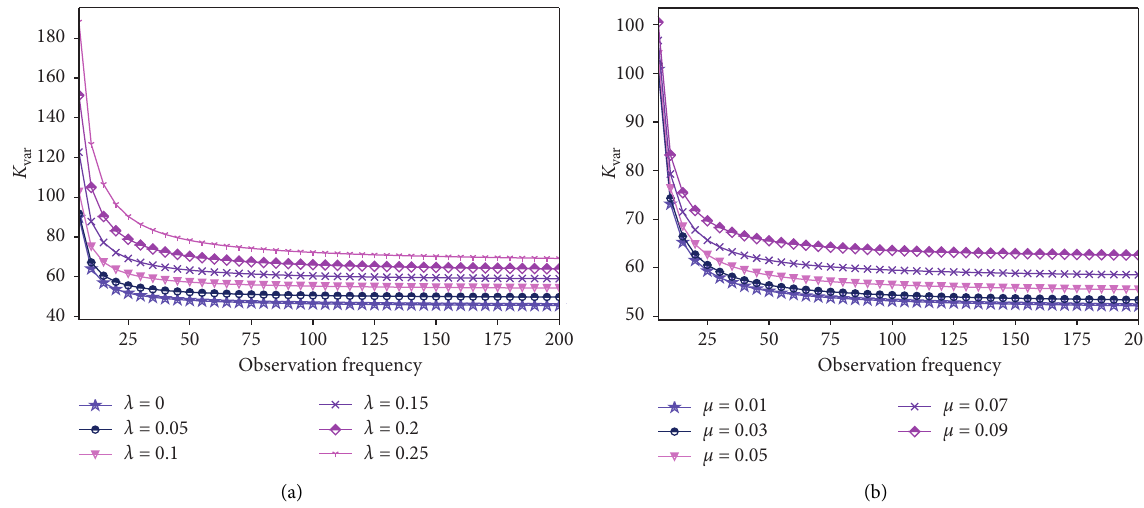
Figure 6: Comparison of K var with the Merton-type jump. (a) Comparison of K with different mean.